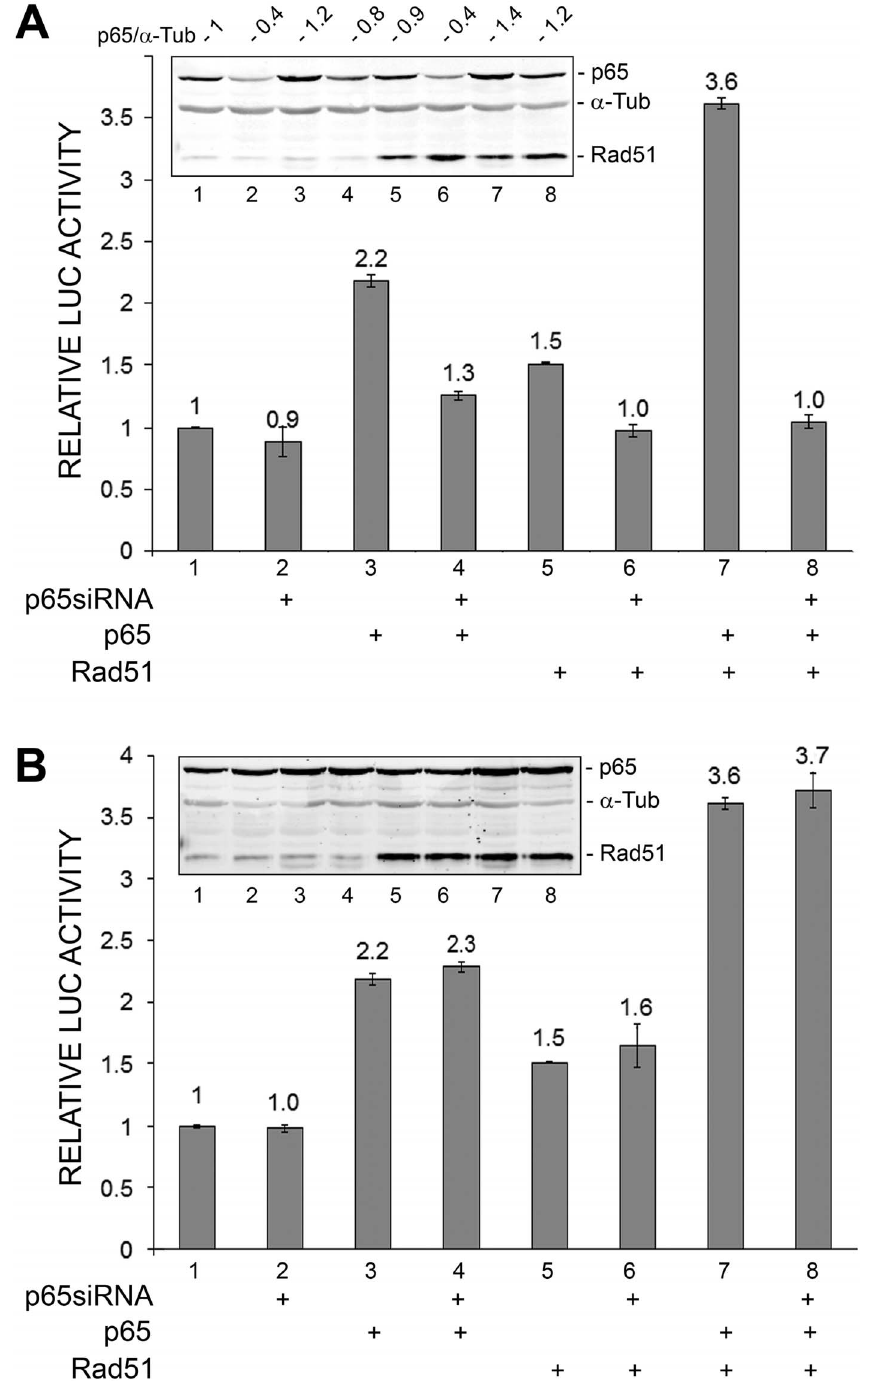
Figure 3. Effect of ectopic expression of Rad51 and siRNAs on JCV early promoter reporter expression. A. TC620 cells were transfected with JCV E -LUC reporter plasmids and expression plasmids for Rad51 (0.5 m g) and p65 (0.5 m g) and/or siRNA for p65 (200 nmol) in various combinations as indicated. After 48 h, cells were harvested and assayed for luciferase activity. Activities were normalized to the activity for reporter alone. The error bars represent standard deviation. Western blot is shown as an inset subpanel within the luciferase activity histogram. The lane numbering in the Western blot corresponds to the numbering in the luciferase assay histogram. The ratio of the quantified relative intensities of the p65 to the a -tubulin bands for each lane are given above the blot to indicate the extent of p65 knockdown. B. As for Panel A except that non- targeting (NT) siRNA (200 nmol) replaced p65 siRNA. This was performed in the same experiment as Panel A but is shown separately for clarity of presentation.